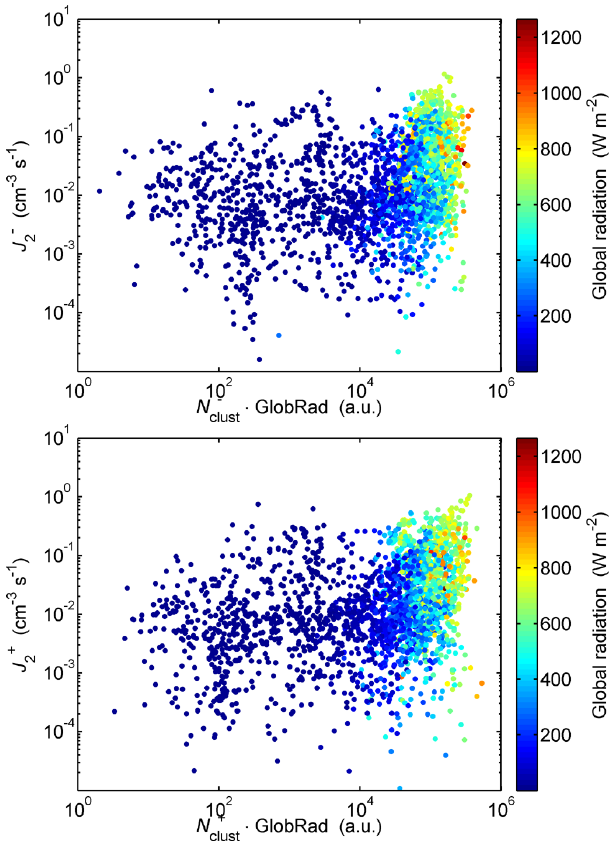
Fig. 4. Formation rates of (a) negative and (b) positive 2nm ions as a function of product of cluster ion concentration and square of global radiation. The blue points mark data from the 12 EUCAARI sites data sets, and the black lines are linear least-squares fits to these data points. The data includes all times when global radiation intensity is above 50Wm − 2 . Correlation coefficients between the observed and parameterized formation rates are r = 0 . 44 and 0.41 for negative and positive ions,